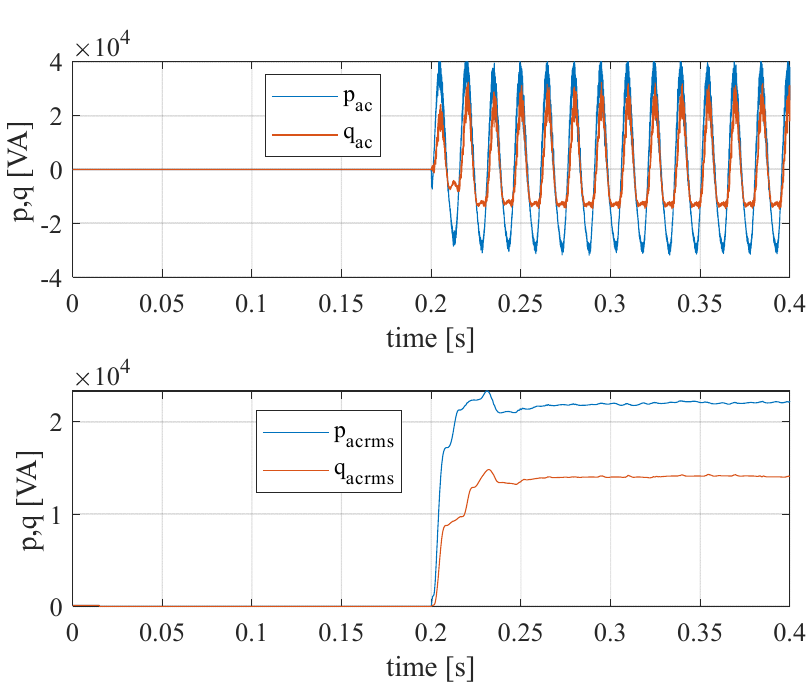
Figure 25. AC components of power during parallel cooperation and compensation oscillating torques.